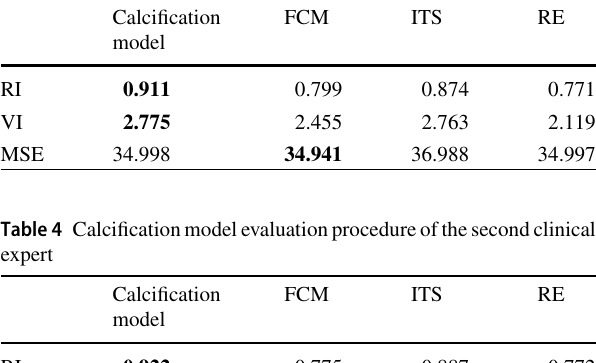
mentation are expected. These subjectively defined intervals should be verified on a base of the median which is robust against outlying observations. The interval estimation of the median is proved on a base of the Gastwirth median esti- mation. Interval median estimation with reliability 95%